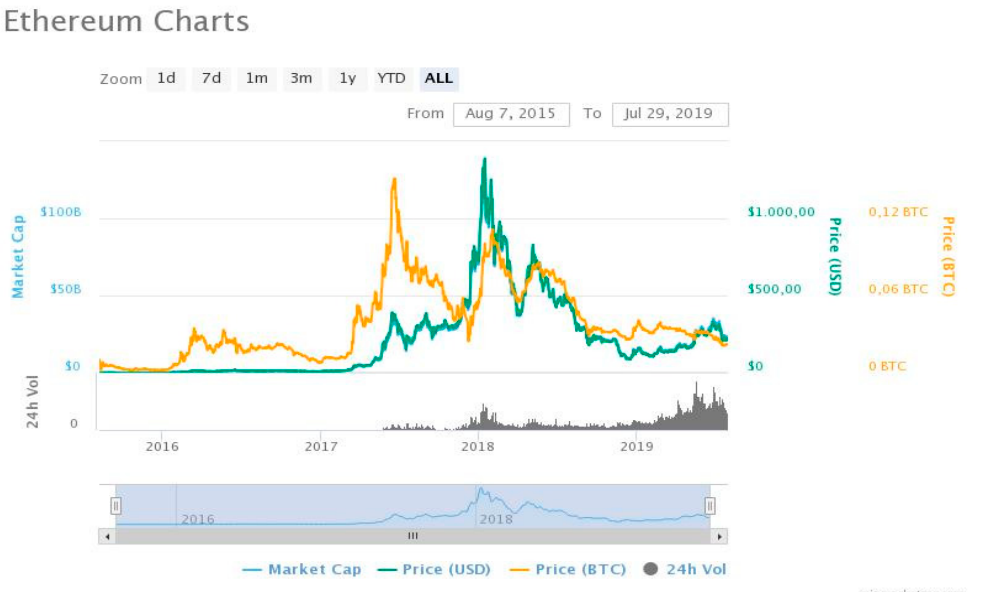
J. Sens. Actuator Netw. 2020 , 9 , x FOR PEER REVIEW Figure 14. Chart of Ethereum price. Figure 14. Chart of Ethereum price.